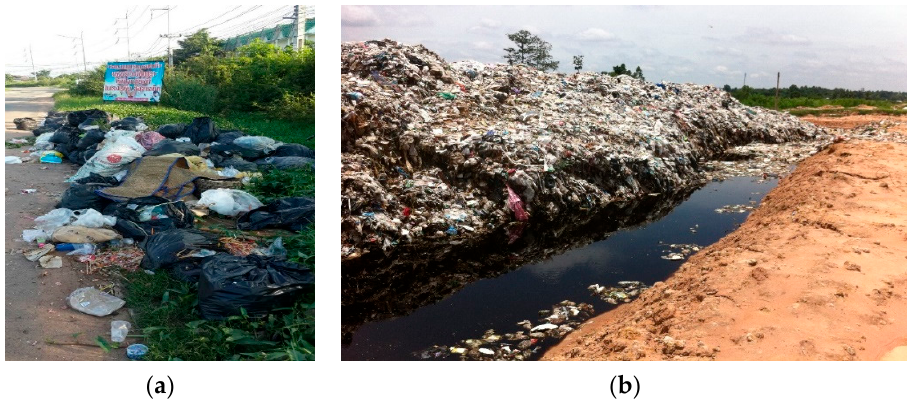
Figure 1. ( a ) Typical scene of road-side waste in Tha Khon Yang; ( b ) Landfill site of Maha Sarakham Municipality.